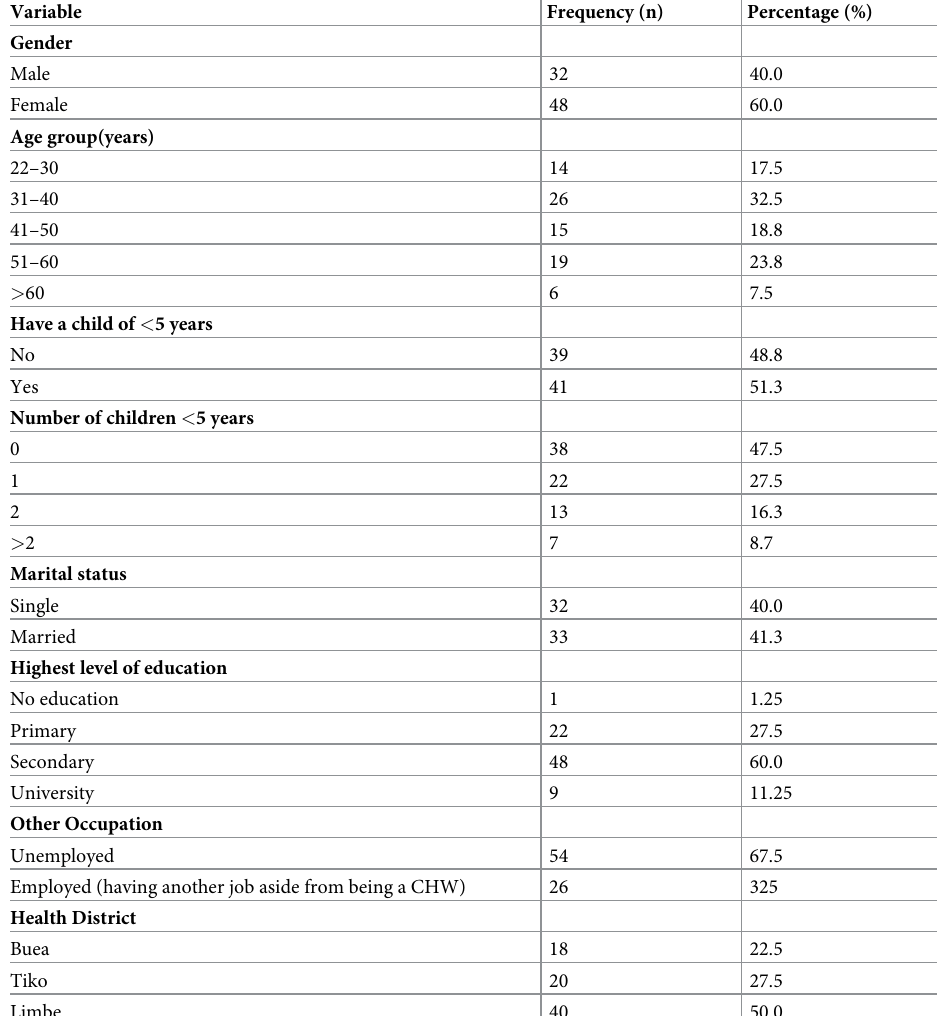
Table 1. Socio-demographic characteristics of participants (n =